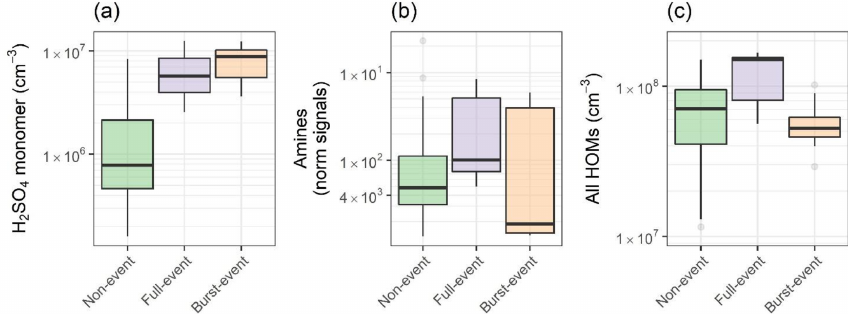
Figure 3. Box plots for days of non-event, full-event and burst-event, showing (a) sulfuric acid, (b) C 2 and C 4 amines, as clustered with the nitrate dimer and trimer, and (c) summed HOM concentration from C 5 + from hourly data. Units for ammonia + amines are normalised counts, as no calibration was performed. Event days include data across the full-event day.